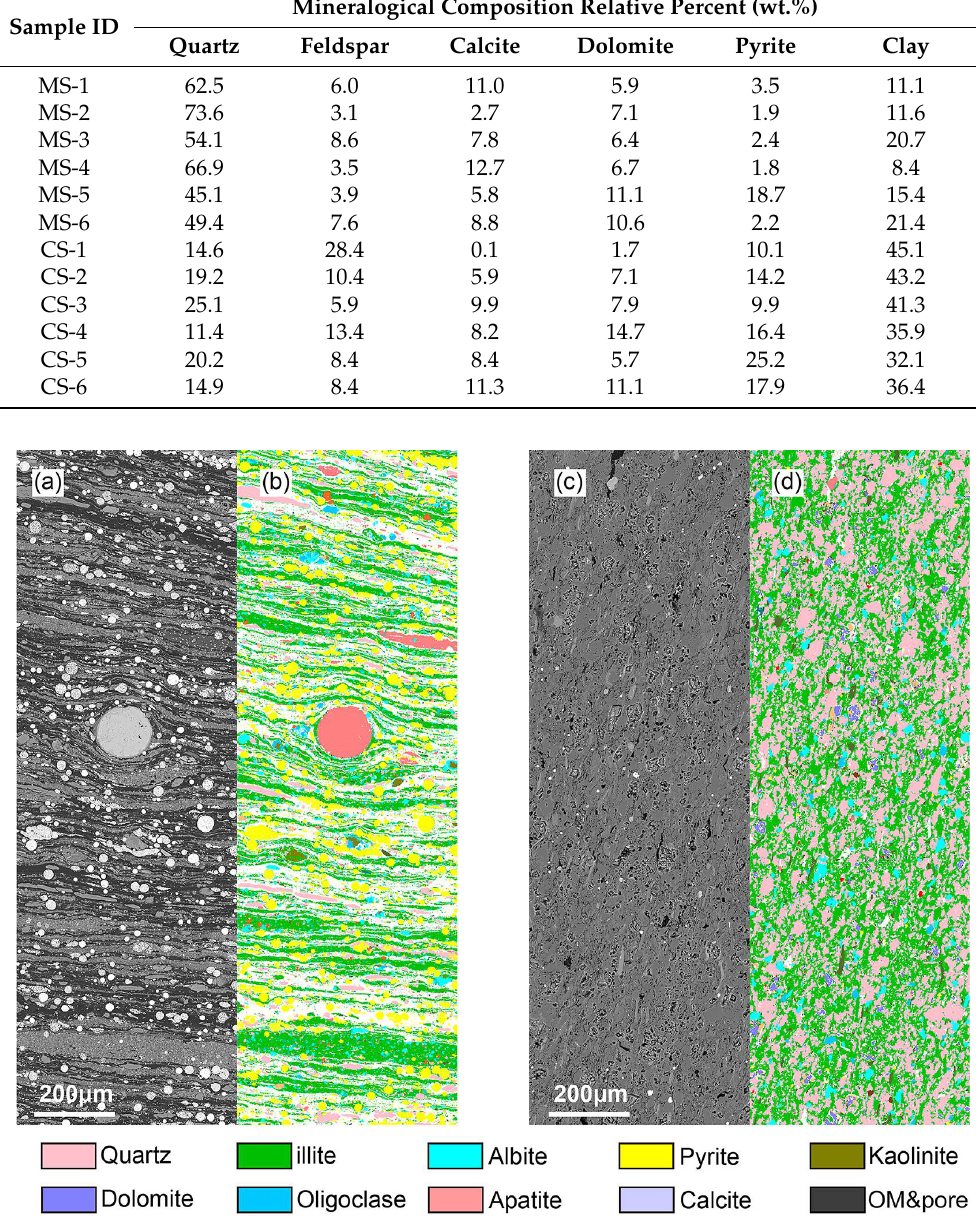
Figure 3. The SEM and the mineral identification image by AmicSCAN, ( a ) The SEM of continental shale; ( b ) AmicSCAN image of continental shale; the illite layer presents a significant lamellar distribution; ( c ) the SEM of marine shale; ( d ) AmicSCAN image of marine shale, there is no obvious orientation of illite. Because of the limitation of X-ray, the OM and pores cannot be detected by AmicSCAN, and the color of OM&pore legend refers to the SEM image ( a , c ).